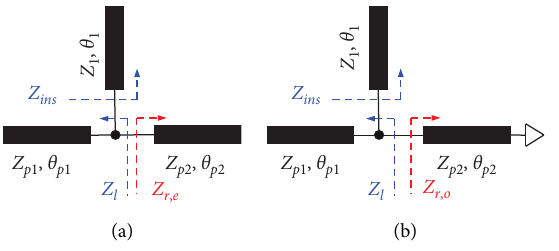
Figure 2: Symmetrical branch resonator equivalent circuit. (a) Even mode circuit; (b) odd mode circuit.